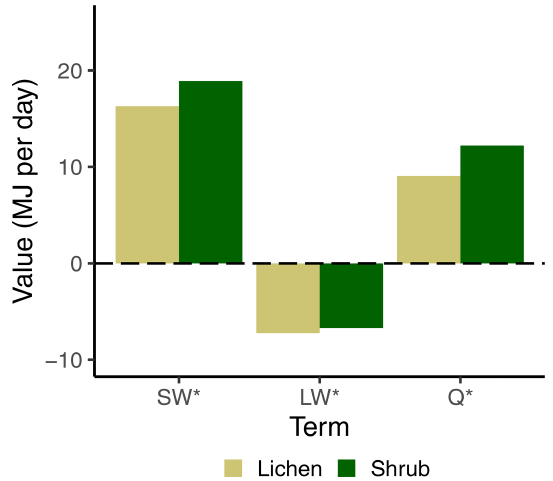
Figure 6. Average radiation balance for all lichen and shrub plots of the entire field season of 2018. SW ∗ = SW in − SW out and LW ∗ = LW in − LW out